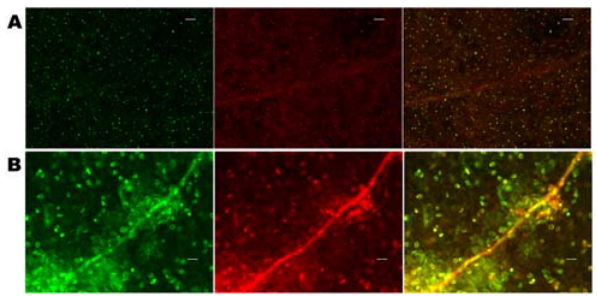
Figure 7. Multiple dyes reveal the same characteristic changes of seedlings infected with P.aeruginosa or P.syringae pv. tomato . Seedlings were stained 3 dpi with membrane impermeable dye Sytox green (SG) in combination with propidium iodide (PI)–another cell impermeant nucleic acid stain after infection with ( A ) P. syringae pv. tomato DC3000 (PA14), ( B ) P. aeruginosa . Left: SG staining, middle: PI staining, and right: merge of both. Scale bar indicates 50 m m.